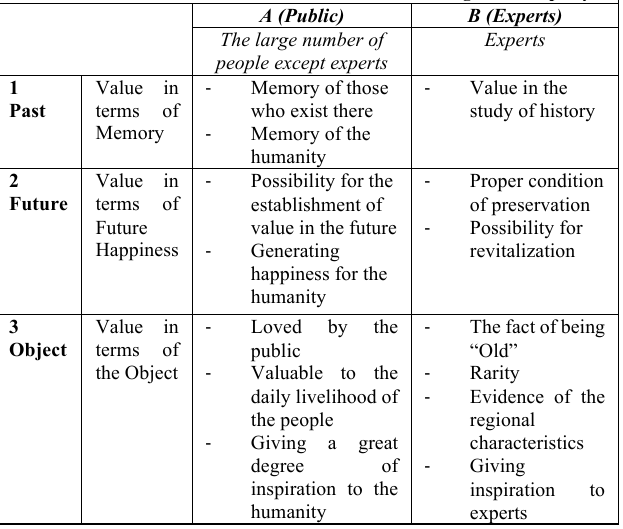
Table 1. The six factors to evaluate heritage architecture